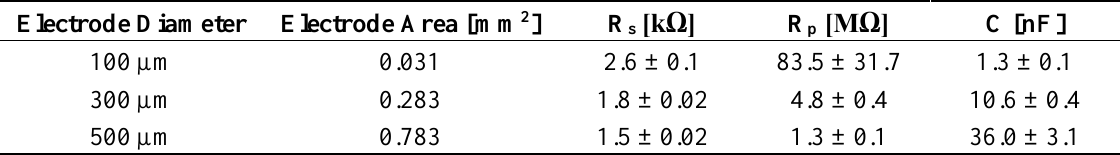
Table 1. Parameters of the electric circuit model (mean + s.e.m): C is the double-layer capacitance, R p the charge transfer resistance and R s the path + saline